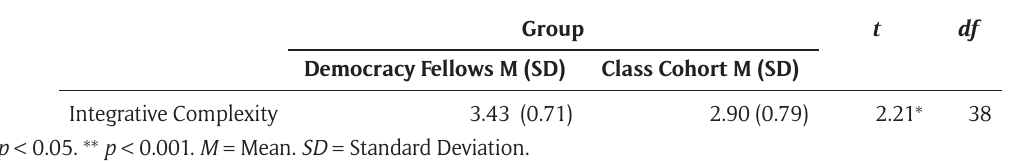
Table 2: Integrative Complexity in Thinking About Citizenship Among Democracy Fellows and the Class Cohort.